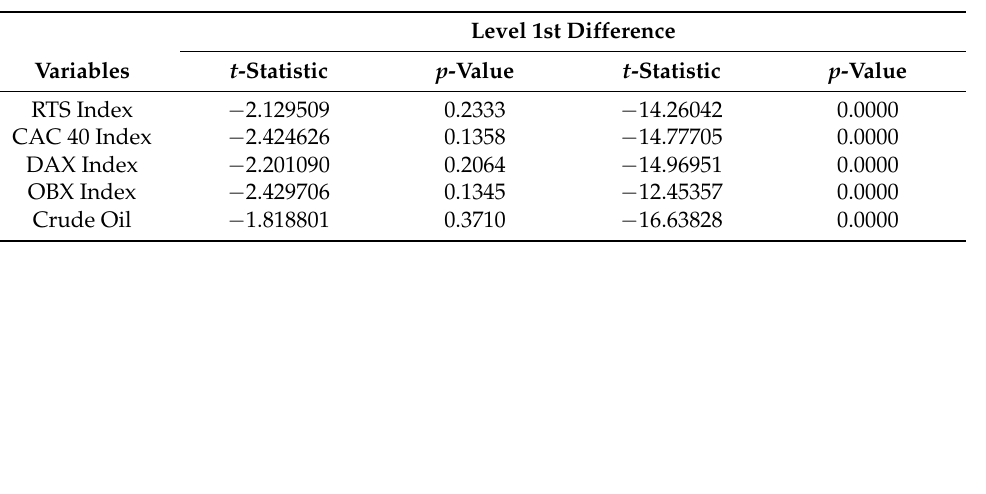
Table A1. Augmented Dickey–Fuller Test Results (Pre-COVID